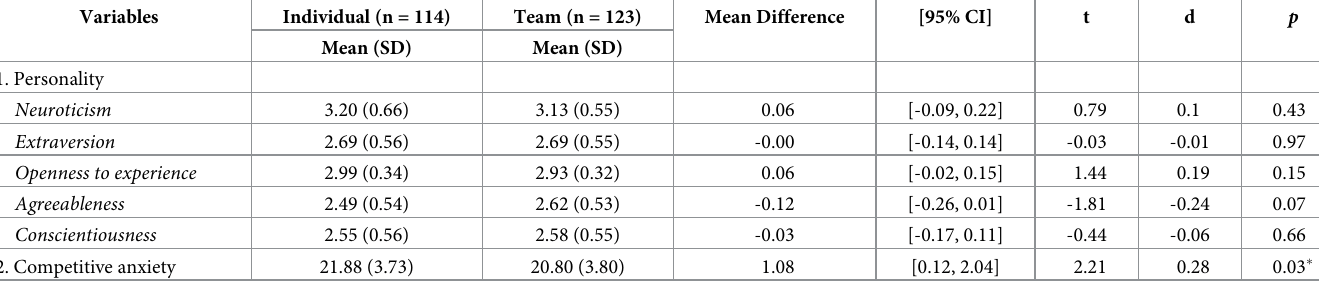
Table 1. Comparisons of personality and competitive anxiety between individual and team athletes.